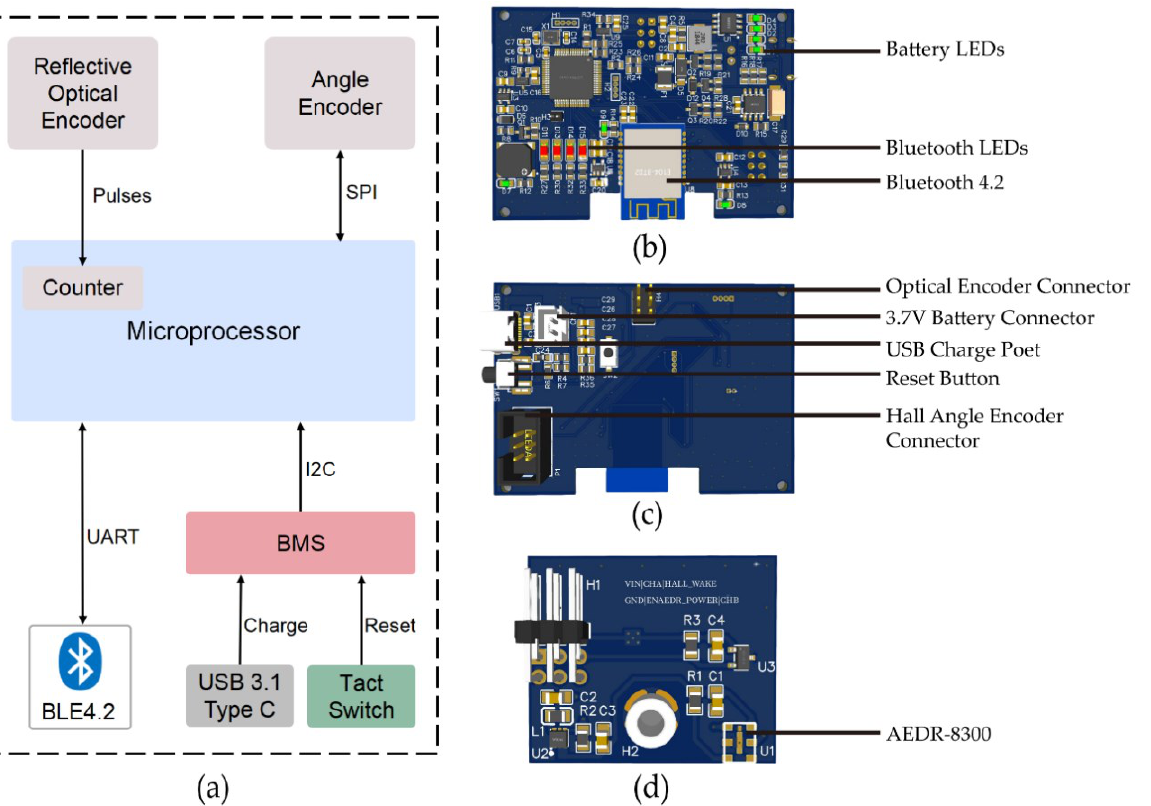
Figure 3. Electronic connections: ( a ) diagrammatic drawing; ( b ) the top layer of the main control circuit board; ( c ) the bottom layer of the main control circuit board; ( d ) the layout of the mini circuit board for displacement measurement .